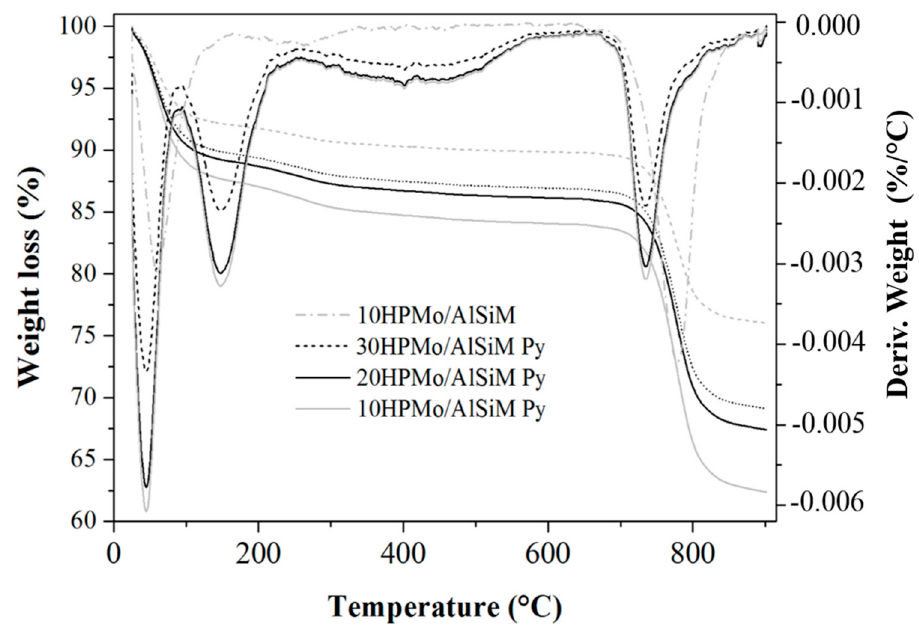
Figure 6. TGA / DTG curves of the catalysts without and with adsorbed pyridine: 10HPMo / AlSiM and Figure 6. TGA/DTG curves of the catalysts without and with adsorbed pyridine: 10HPMo/AlSiM and (10, 20 and 30) HPMo / AlSiM Py; where Py are samples with pyridine. (10, 20 and 30) HPMo/AlSiM Py; where Py are samples with pyridine.